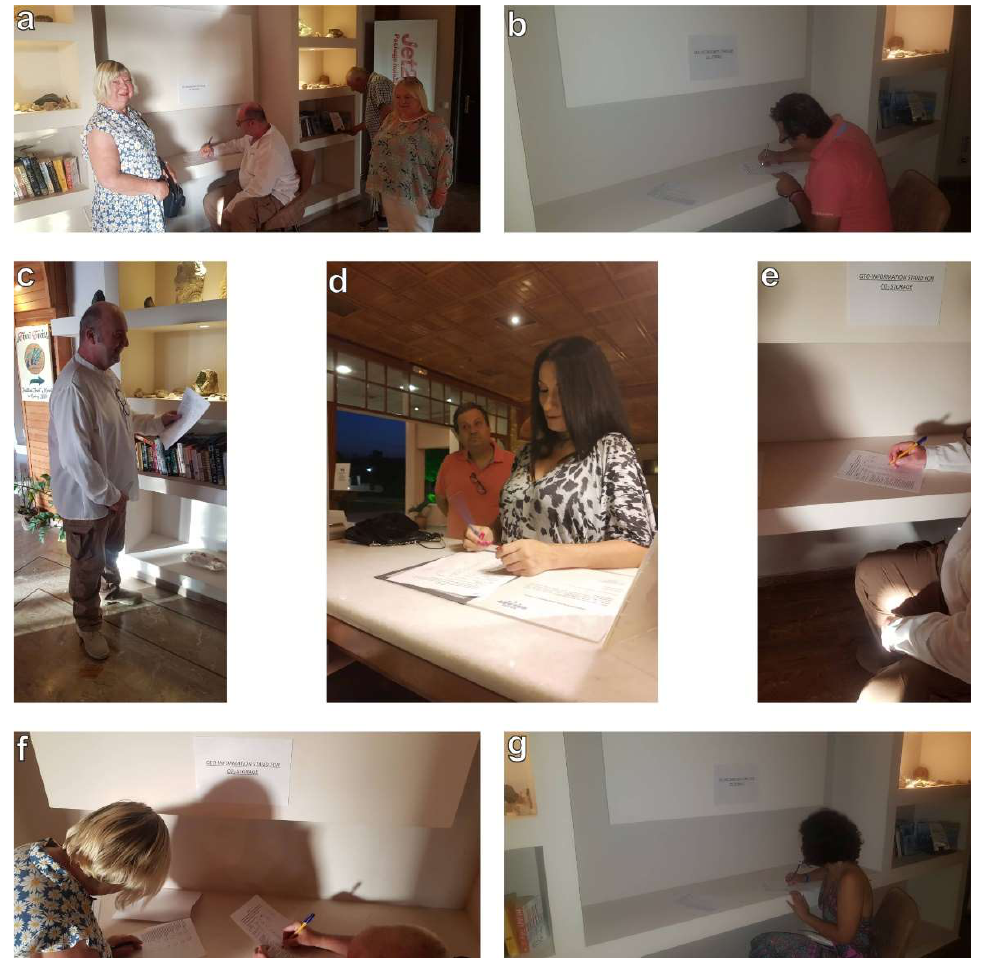
Figure 2. ( a – g ): European citizens completing the questionnaires regarding CO 2 issues at the geological stand of the hotel.